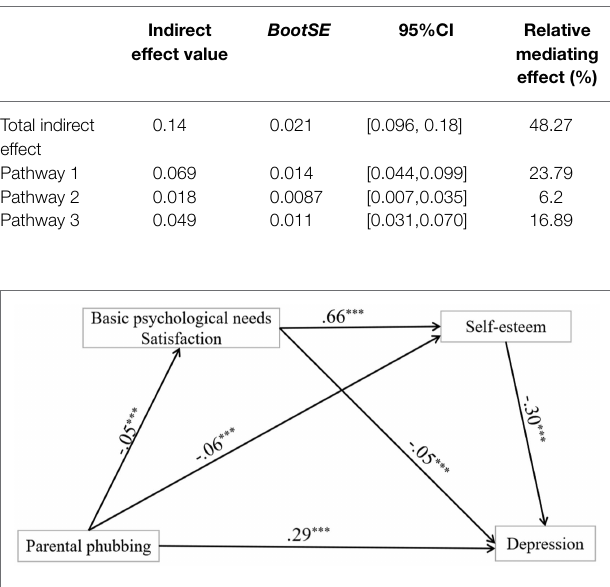
FIGURE 2 | The mediating effect path map of parental phubbing and depression. * p < 0.05; ** p < 0.01; and *** p <